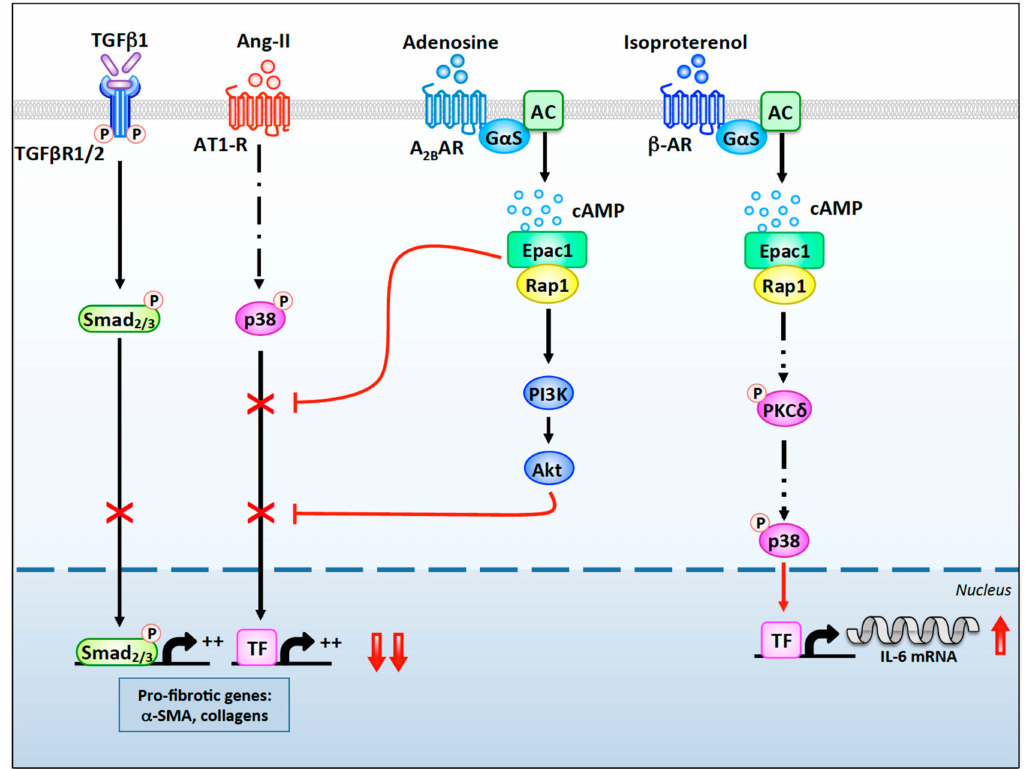
Figure 2. The anti- and pro-fibrotic roles of Epac1 in cardiac fibroblasts. Stimulation of A 2B Rs by adenosine leads to the local activation of G α s and AC (AC5 and / or AC6). Generation of cAMP enhances an Epac1-dependent anti-fibrotic pathway involving Rap1, PI3K, and Akt, which inhibits TGF β R1 / 2-Smad2 / 3 and AT1-R-p38 signaling. Epac1 can also inhibit Ang-II- and TGF β 1-induced pro-fibrotic signaling through a Rap1-independent pathway. In contrast, cAMP-mediated activation of Epac1 following β -AR stimulation leads to Rap1-dependent phosphorylation of PKC δ . Once activated, PKC δ translocates to the nuclear region where it activates p38, which enhances transcription of the IL-6 gene through the activation of an uncharacterized transcription factor